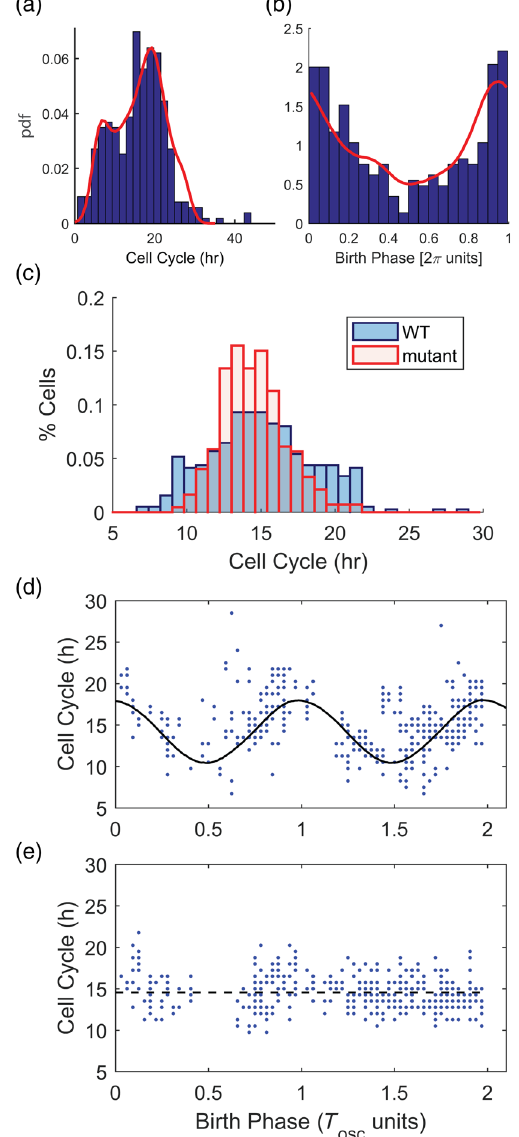
FIG. 4. Comparison between experiments and the kicked cell- cycle predictions. (a) Distributions of the cell-cycle duration of Cyanobacteria 1, with data (blue bars) and model predictions (red lines). The simulatedcell-cycle durationdistribution isbimodal (red line), as the measured one. (b) Distribution of phase at birth for the same data as shown in (a). There is a reduction of cell division for certain phases, i.e., gating, as predicted by the model (red line). (c)MutantofthestrainofCyanobacteria2deletedfortheclockgene (red),displayingasignificantlysmallercoefficientofvariation(CV) compared to the WT (blue). (d),(e) Cell-cycle duration as a function of time (in T units), synchronized to the circadian clock, for osc Cyanobacteria2(d)andaclockmutant (e),withdata(bluedots)and modelprediction[blacklinein(d)].Thedashedlinein(e)represents the experimental mean of the mutant cell-cycle